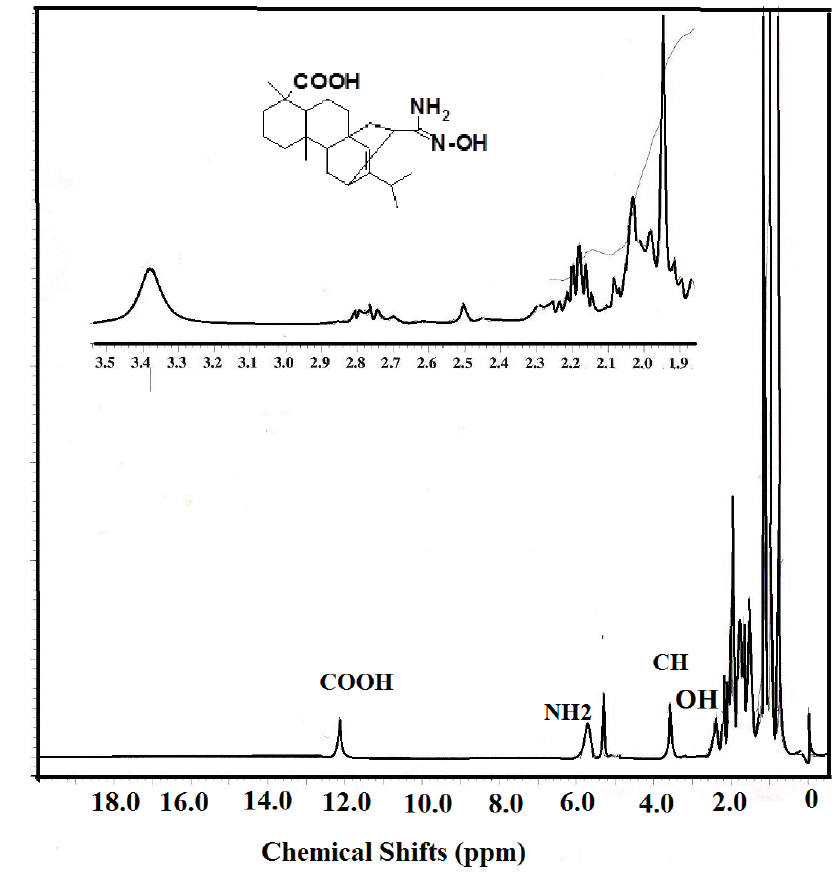
Figure 2. 1 H NMR spectrum of R-AN amidoxime.